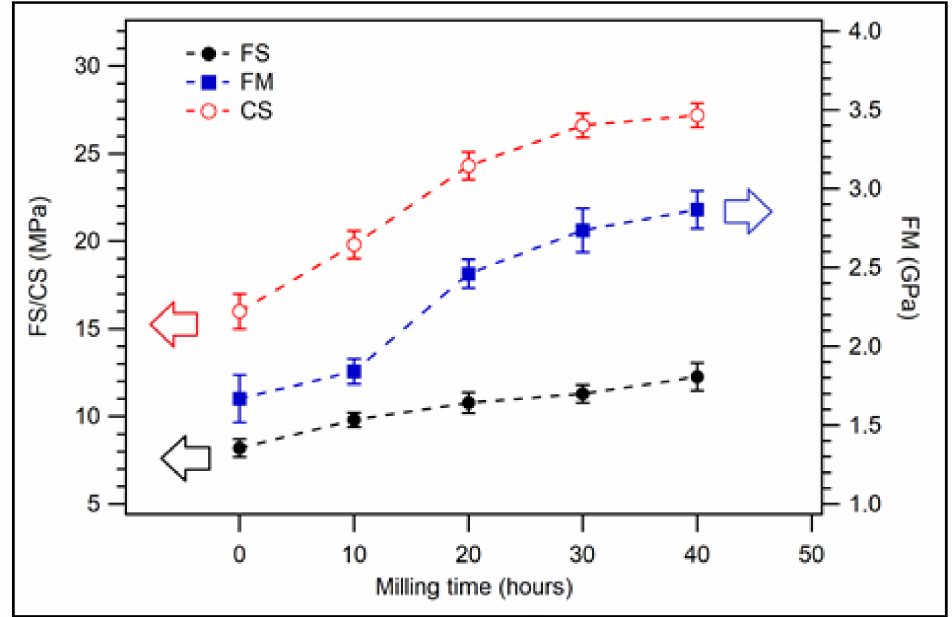
Figure 7. Mechanical properties of coconut shell nano-biocomposite for various milling times with 30 wt.% of PP